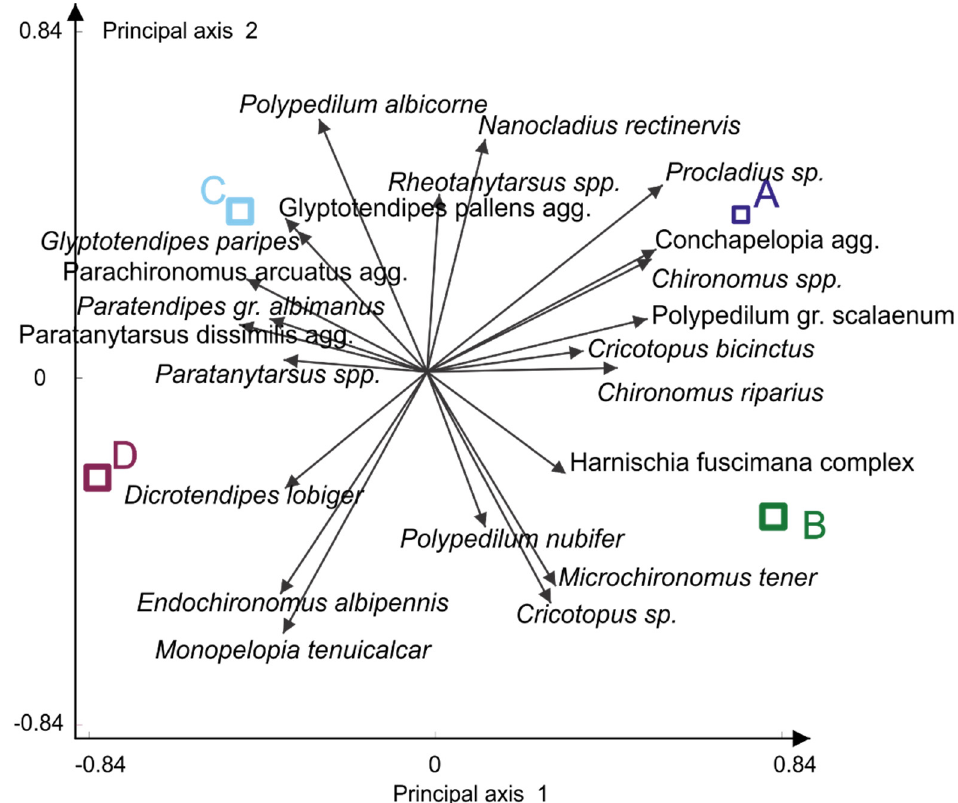
Figure 2. Multivariate analyses of variance (MANOVA) of four Chironomidae assemblage clusters. Four assemblage types (obtained through K-means clustering) are in capital letters A, B, C, D coloured as indicated.